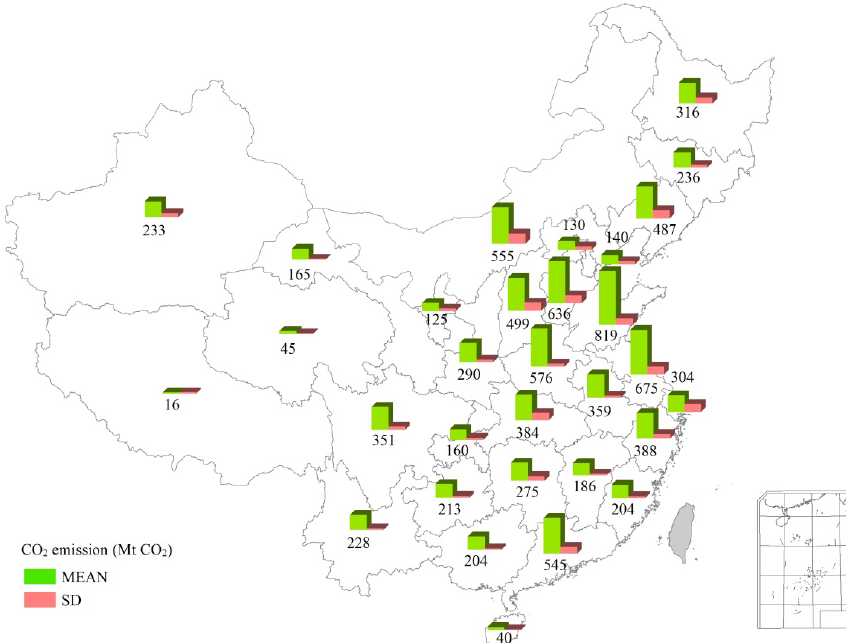
Figure 4. Provincial mean total emissions for ODIAC, EDGAR, PKU, CHRED, MEIC, and NJU in 2012. The numbers beneath the green bars are the provincial total CO 2 emissions in